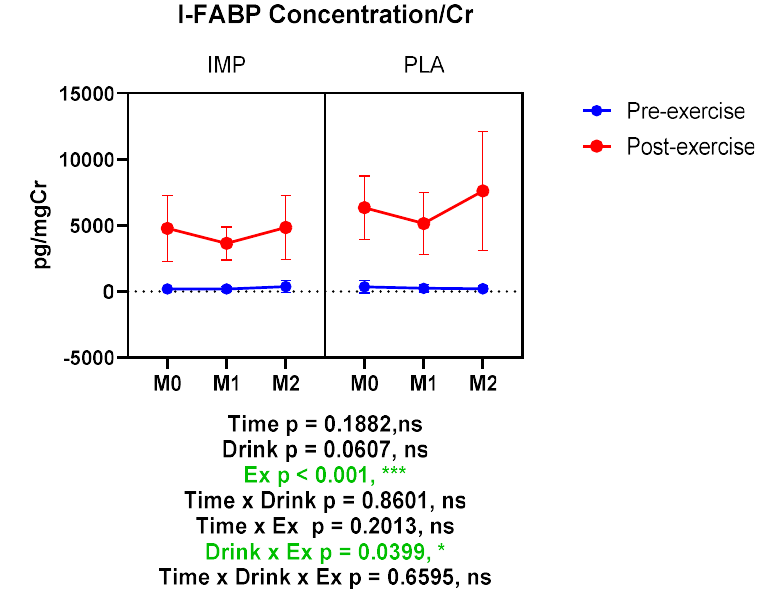
Figure 5. Urine intestinal fatty acid binding protein (I-FABP) concentration corrected with creatinine. The data are presented as means ± SD. * p < 0.05 and *** p < 0.001. Green text indicates a significance <0.05 .